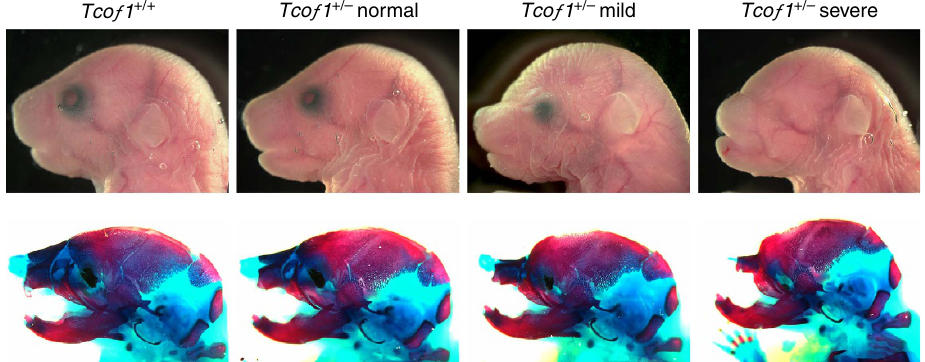
Figure 7 | Pharmacological prevention of craniofacial malformation. Tco f 1 þ / (cid:2) embryos were treated with (NAC) or without (control; PBS) antioxidant in utero from E5.5 to E10.5 (short) or to E17.5 (long) via daily intraperitoneal injection of pregnant mothers. Embryos were collected at E18.5–19.0 and subjected to skeletal analysis. Both short- and long-term antioxidant supplementation repressed the severe phenotype and ameliorated the presence of craniofacial anomalies in approximately 30% of treated